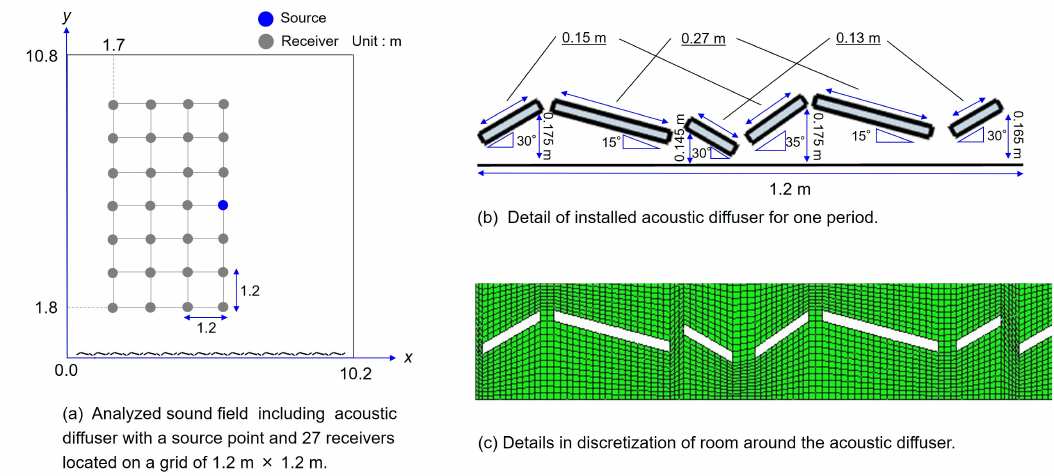
Figure 8. ( a ) Analyzed sound field including acoustic diffuser with a source point and 27 receivers located on a grid of 1.2 m × 1.2 m. ( b ) Details of installed acoustic diffuser for one period. ( c ) Details of discretization of the room around the acoustic